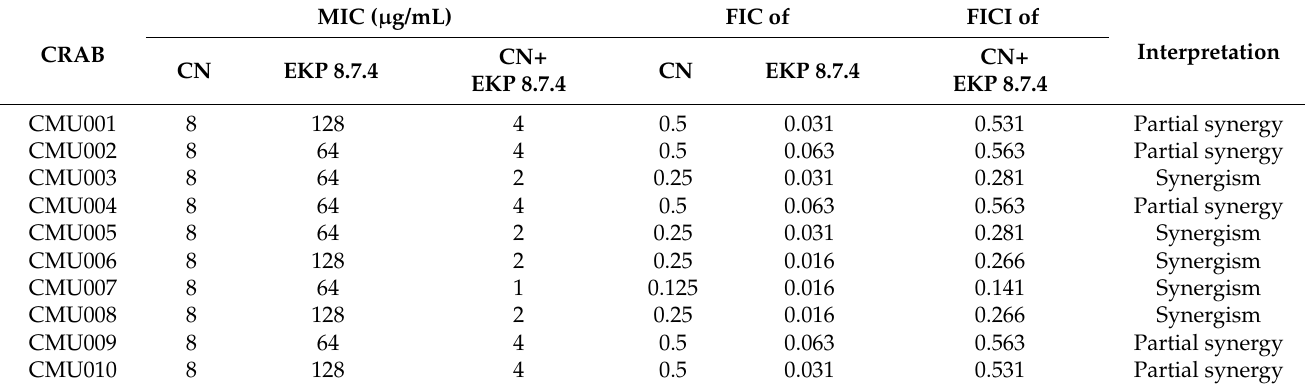
Table 10. Combination effect of gentamicin and EKP 8.7.4 extract against